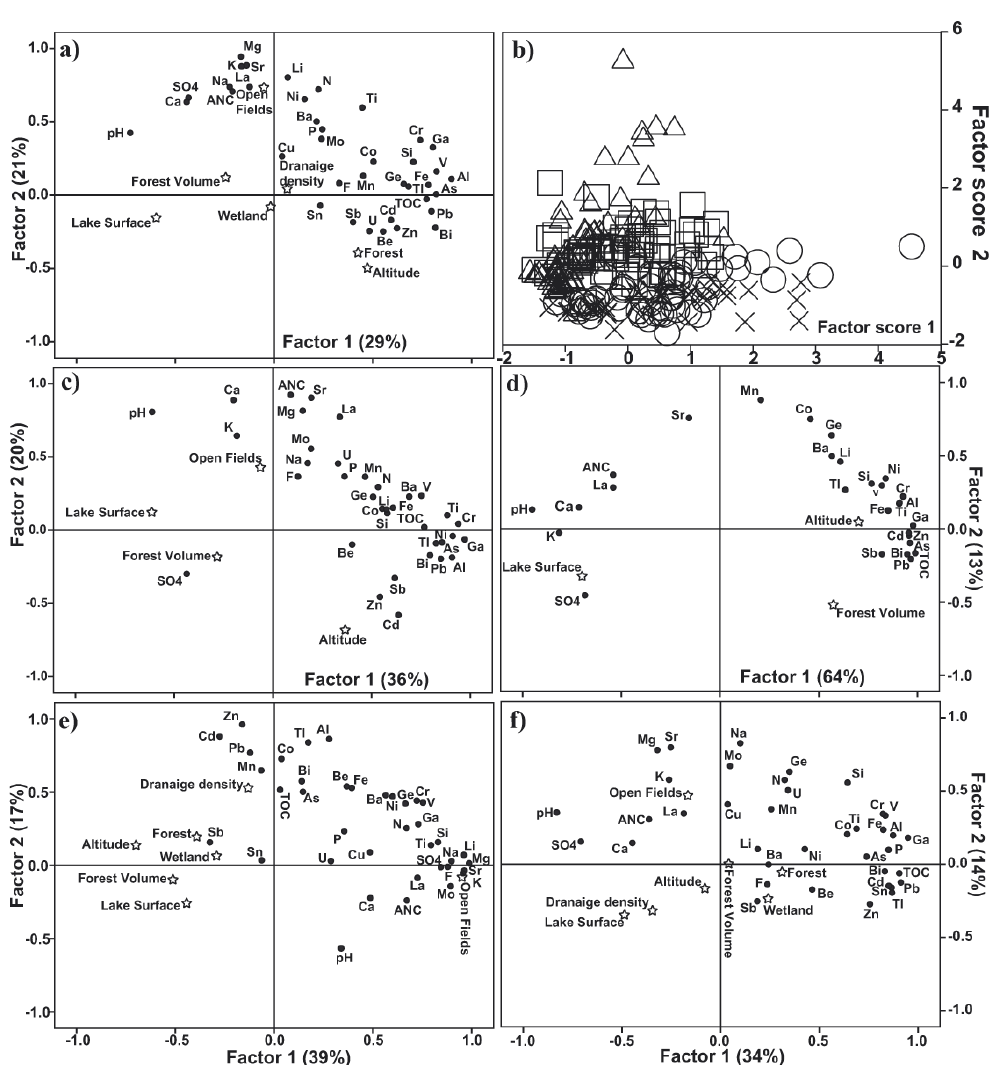
Fig. 5. Common factor analysis of water chemistry and map material (Table 1): (a–b) data from all four rivers, where (a) is the loading plot, (b) is the score plot. Loading plots for (c) Danshytte˚an (R. D.), (d) Getryggs˚an (R. G.), (e) Anr˚ase ˚a (R. A.) and (f) Lugn˚an (R. L.). In (b) R. A. is represented by triangles, R. L. by open squares, R. D. by open circles and R. G. by crosses. For (a) and (c–f) black dots are water chemistry and open stars are physical parameters (map